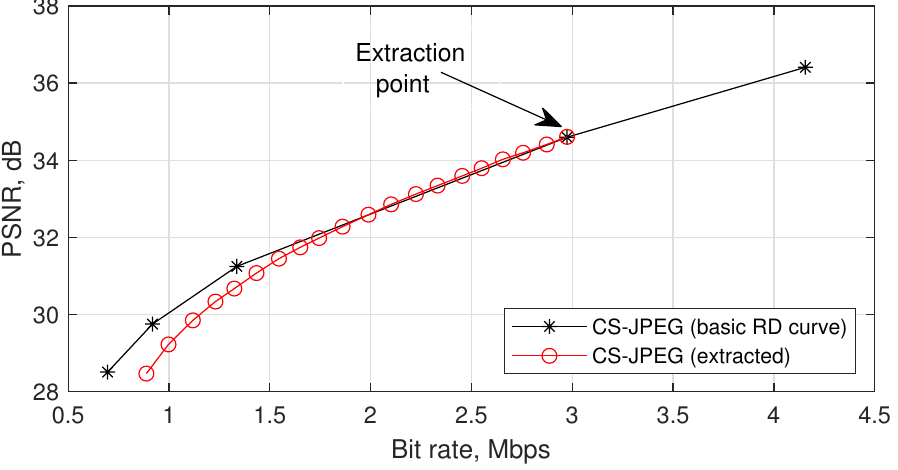
Figure 2. Illustration of the codec scalability for ‘Foreman’.